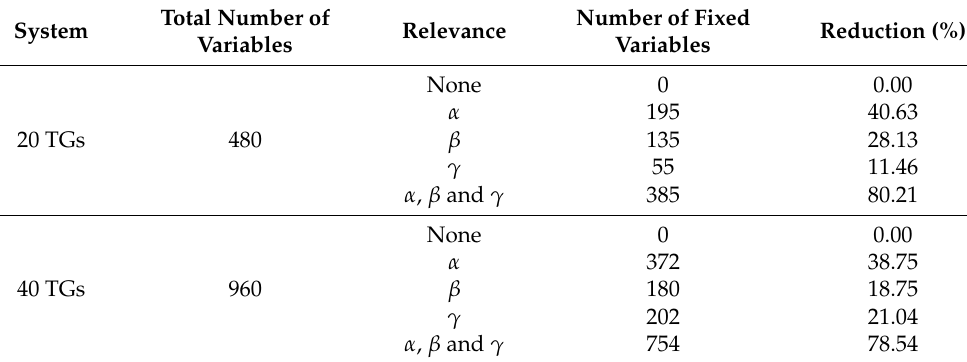
Table 10. Number of fixed